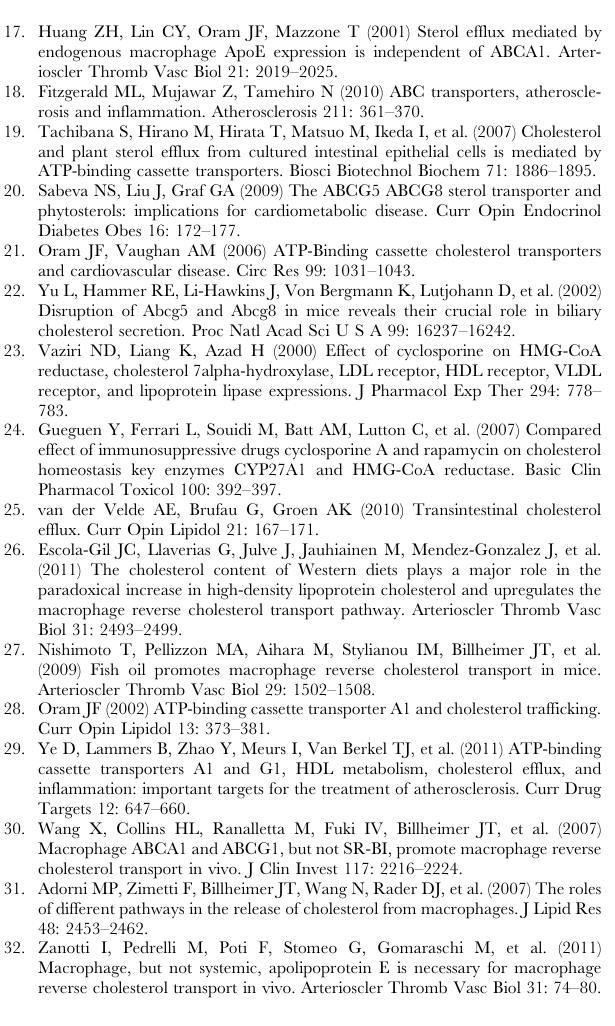
Table S3 Effect of 14 day treatment with CsA on body weight in mice injected with J774. C57BL/6 mice were treated with CsA as described in Figure 1. Body weight was measured at baseline, on day 7 and on day 14 of the pharmacological treatment. Data are presented as mean 6 SD (n= 5). Table S4 Effect of 14 day treatment with CsA on liver weight in mice injected with J774. C57BL/6 mice were treated with CsA as described in Figure 1. Body weight was measured at baseline, on